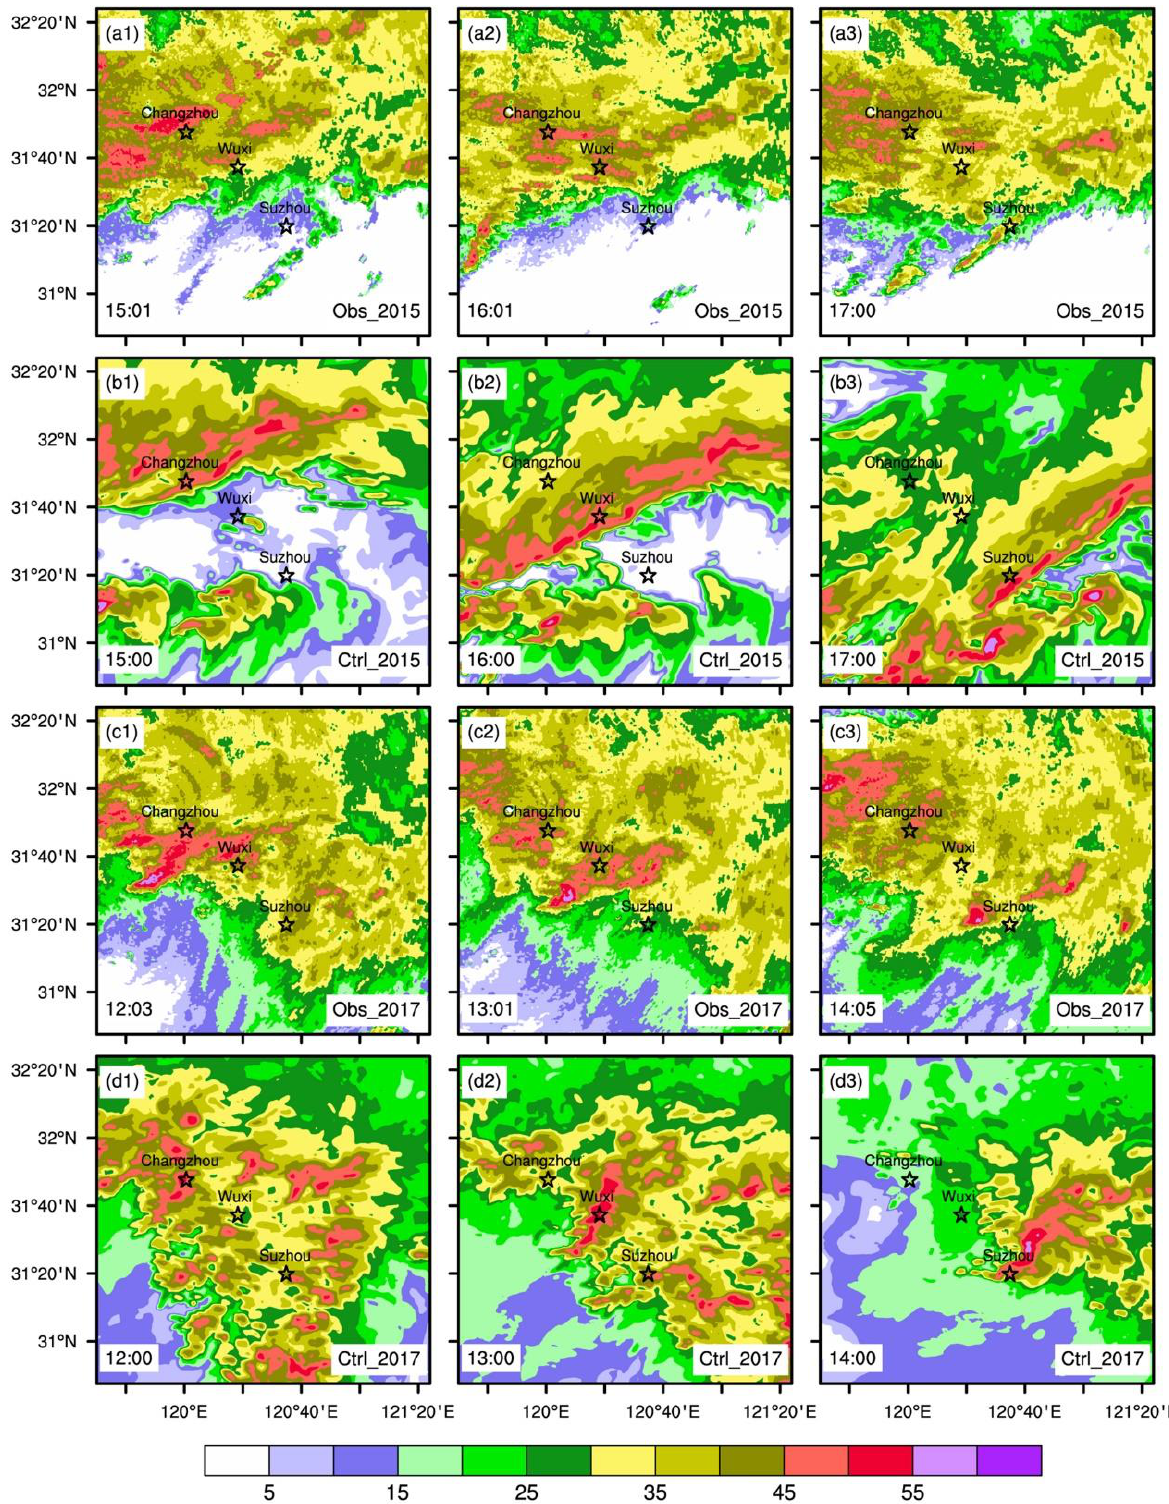
Figure 5. The distributions of ( a1 – a3 ) radar composite reflectivity and ( b1 – b3 ) simulated composite radar reflectivity (unit: dBZ) for EP627. ( c1 – c3 , d1 – d3 ) is the same as ( a1 – a3 , b1 – b3 ), but for EP925.